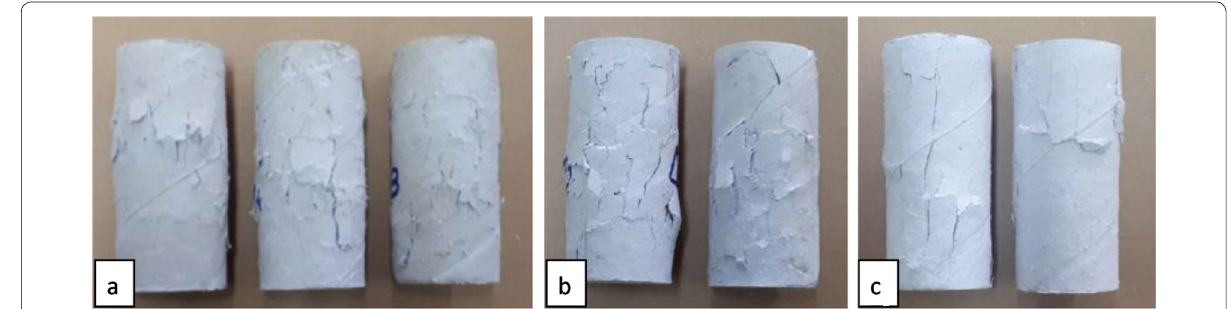
Fig. 2 Fracture types of the seven “gypsum-filling materials” combinations tested. From left to right: a office paper, newspaper, magazine paper, b testliner–kraftliner–fluting papers, paperboard, c Tetra Pak I, Tetra Pak